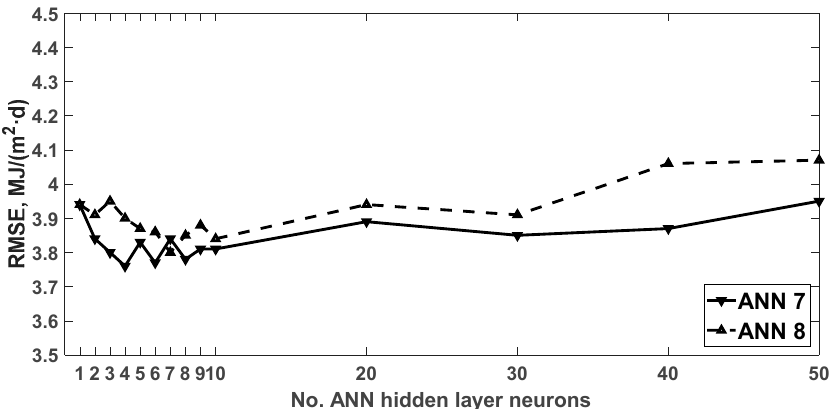
Figure 4. Horizontal daily global solar irradiation effectiveness of prediction the day after simulated with the ANN 7 and ANN 8 models, compared with the variable measured values, in 2011, as a function of the neurons number in the hidden layer.